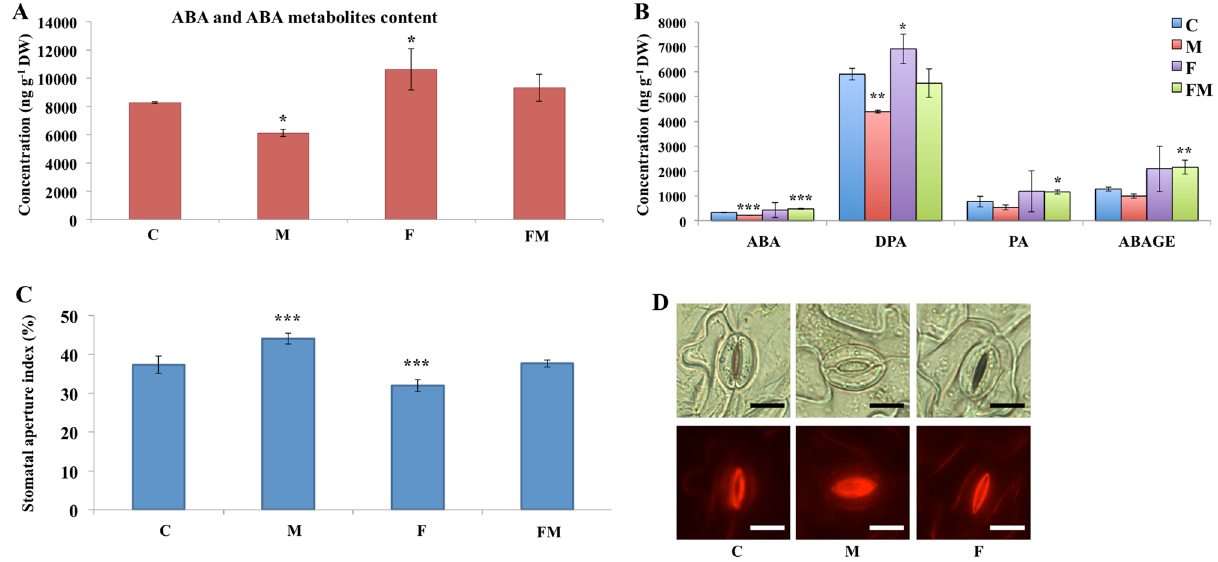
Figure 1. ABA and metabolites and stomatal apertures sizes in bean leaves. Bean leaves were collected at 14 days in un-inoculated control (C), plants colonized by M. robertsii (M), F. solani (F), or M. robertsii together with F. solani (FM). ( A ) Total amount of ABA metabolites in bean leaves of un-inoculated control and bean colonized by different fungi. ( B ) Details of ABA and ABA metabolites in bean leaves of un-inoculated control and bean colonized by different fungi. cis -Abscisic acid (ABA), Dihydrophaseic acid (DPA), Phaseic acid (PA), Abscisic acid glucose ester (ABAGE). ( C ) The stomatal aperture index in bean leaves after 14 days in un-inoculated control and bean colonized by different fungi. Standard deviations are shown. Data were analyzed by one-way ANOVA with Fisher’s least-significant difference (LSD) test. Statistical differences shown; Asterisks indicate statistically significant differences relative to un-inoculated control, * P asterisks, ** P < 0.01, *** P < 0.001 . D, Light microscopy (upper panel) and fluorescence microscopy after staining with rhodamine 6G (lower panel) of stomatal apertures in bean under 250 × magnifications. Scale bar is 15 μm.